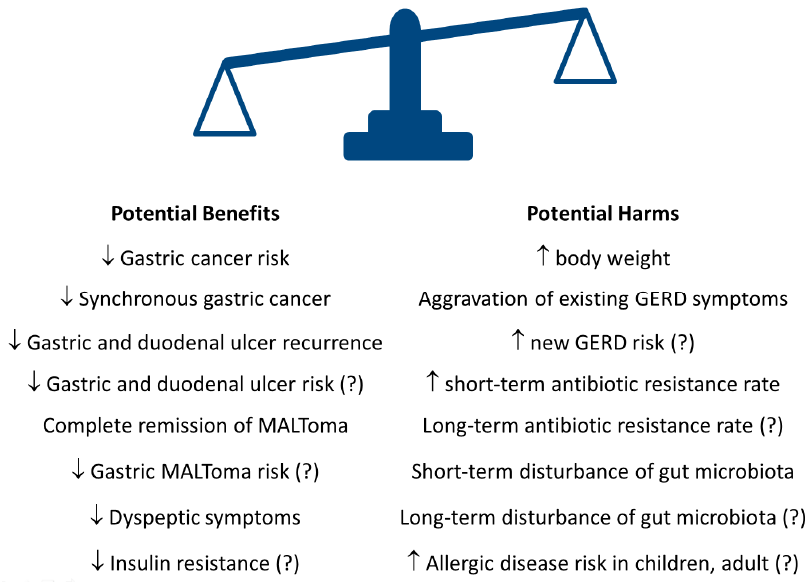
Figure 5. Potential benefits and harms after H. pylori eradication therapy. H. pylori : Helicobacter pylori ; MALToma: mucosa-associated lymphoid tissue lymphoma; GERD: gastroesophageal reflux disease.